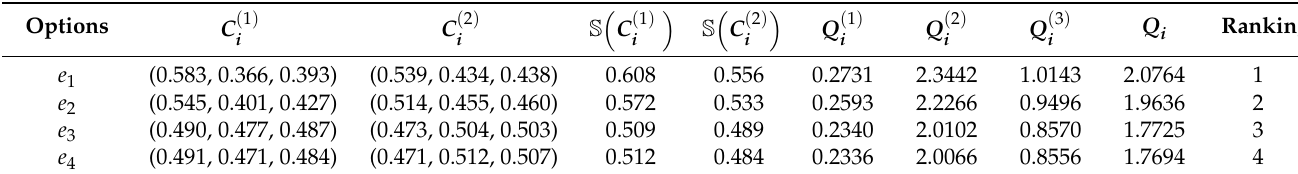
Table 11. Overall compromise ranking outcomes of different